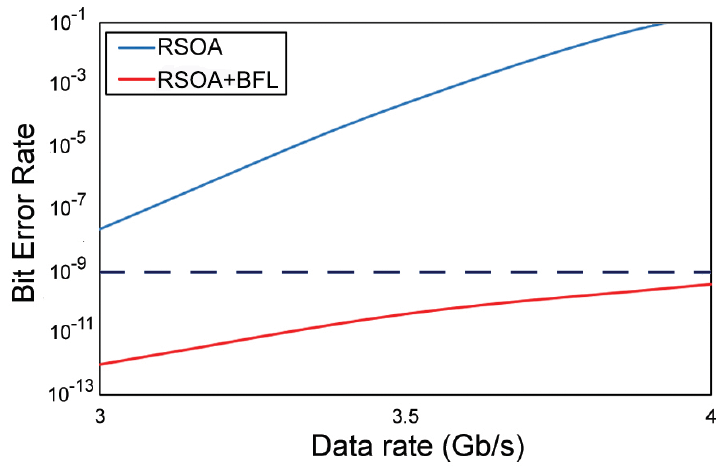
Figure 11. Raw BER measurements versus data rate for BFL detuning ∆ λ = − 0.05 nm. The dashed line indicates the limit for acceptable EP at 1 × 10 − 9 .